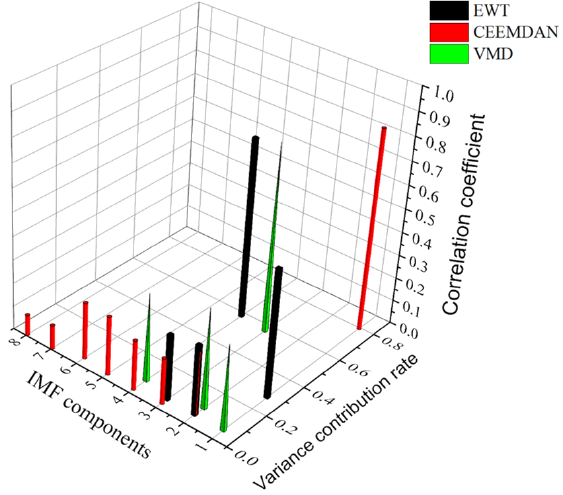
Figure 8. Correlation coefficients and variance contribution rates of IMF components with three different algorithms.